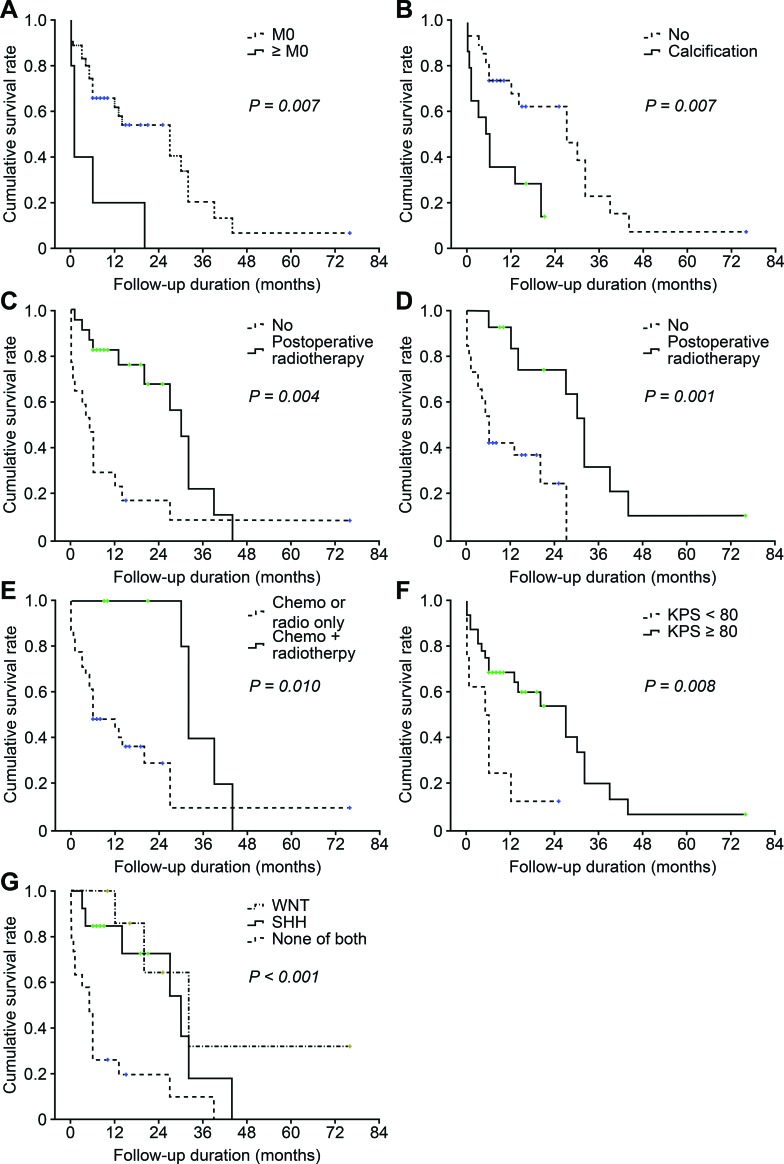
Kaplan-Meier curves of overall survival according to (A) M stage, (B) calcification, (C) postoperative radiotherapy, (D) postoperative chemotherapy, (E) postoperative adjuvant therapy, (F) postoperative KPS score, and (G) molecular subtype. A log-rank test was performed to test the survival status between groups.